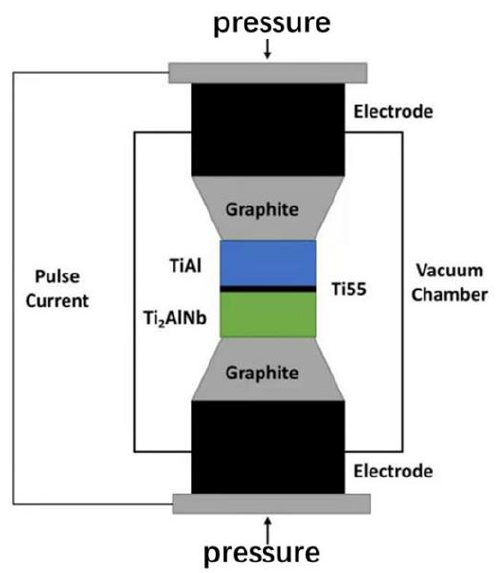
Figure 2. Schematic diagram of spark plasma diffusion bonding.